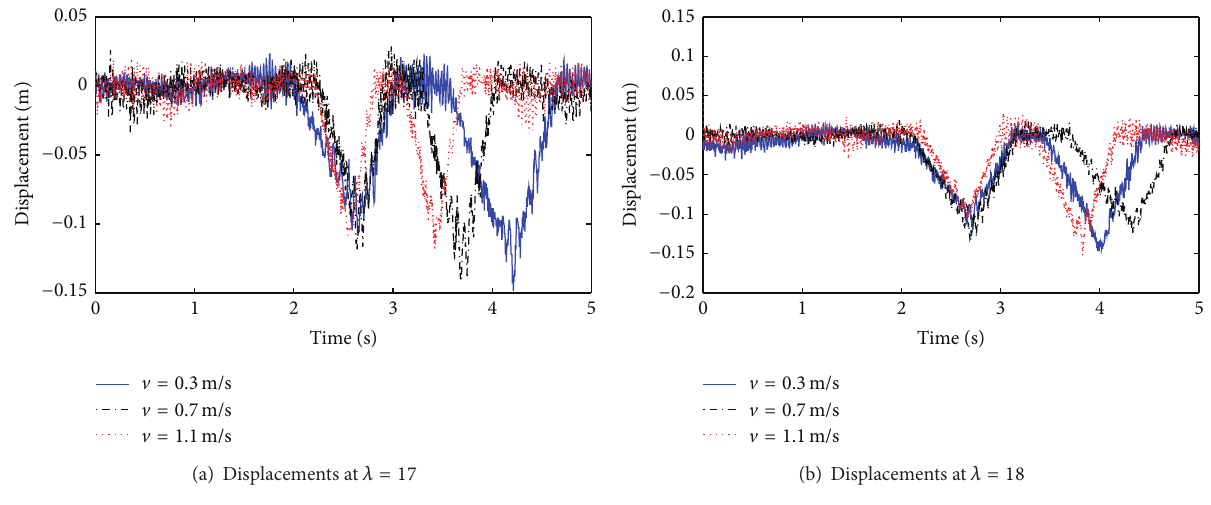
Figure 10: Measured vibrations at the midpoint of the span for different transport